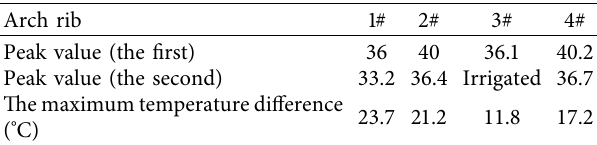
Figure 26: The comparison of calculation results between overall temperature rise of 23.7 ° C and temperature gradient of 23.7 ° C (single chord): (a) the maximum vertical deformation, (b) the stress of the concrete in the vault, and (c) the stress of the steel tube in the vault. Table 4: The peak values of the stress influence lines and the maximum daily temperature difference of each